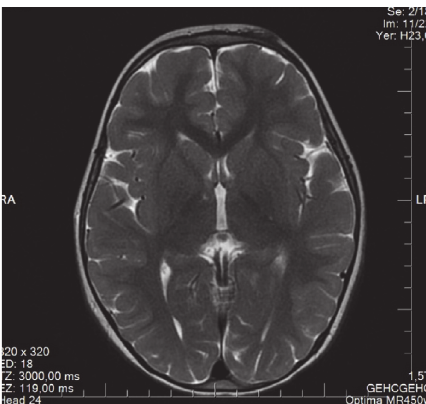
Figure 2: Nonspecific gliosis at subcortical and periventricular deep white